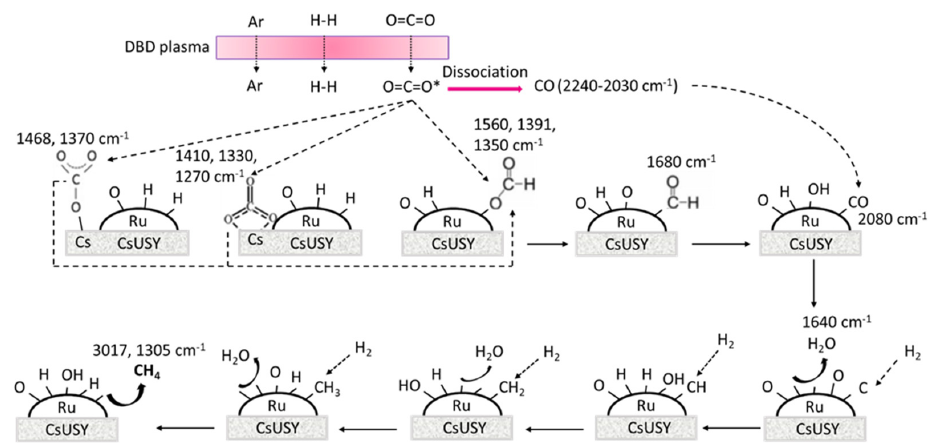
Figure 11. Scheme of the proposed mechanism for plasma-assisted CO 2 methanation over 3Ru/CsUSY.